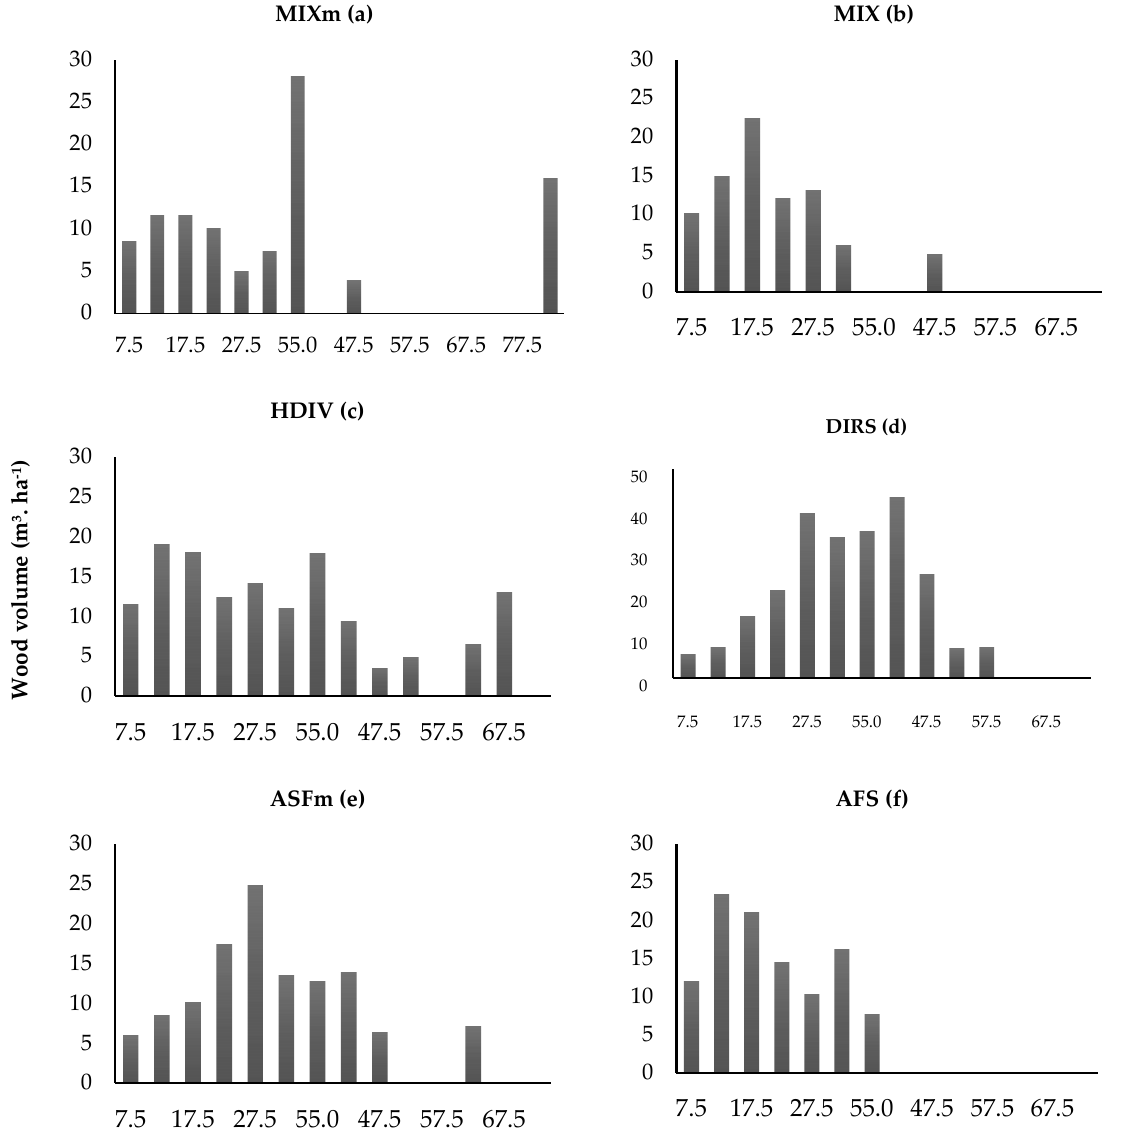
Figure 6 . Wood volume (m 3 . ha −1 ) as a function of DBH (diameter at breast height) classes of different restoration systems of the tropical semi-deciduous seasonal forest after 19–20 years of plantation at Botucatu, São Paulo. Labels: ( a ) MIXm (‘managed‘ commercial mixed plantation), ( b ) MIX (commercial mixed plantation), ( c ) HDIV (high-diversity tree plantation), ( d ) DIRS (direct seeding), ( e ) AFSm (‘managed’ agroforestry system), ( f ) AFS (agroforestry system). Analyses were performed for pooled sites data.